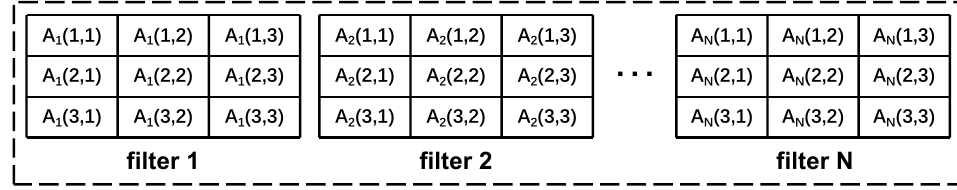
Figure 4. N filters for the k -th layer neural